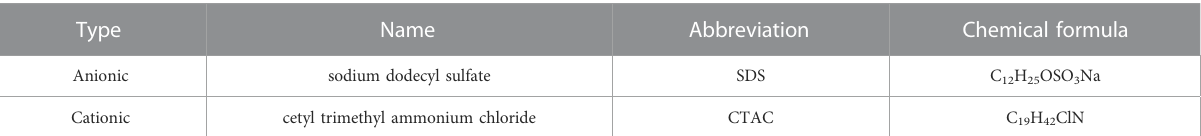
TABLE 3 Introduction of